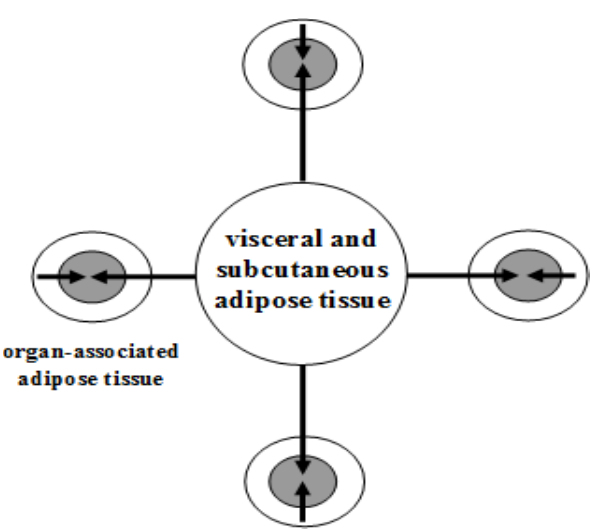
Figure 1. The topography of white adipose tissue. Schematic illustration of a large adipose depot (visceral and subcutaneous adipose tissue) and small adipose depots (organ-associated adipose tissue). Dual action of adipokines, via endocrine pathway (long arrows) and via paracrine pathways (short arrows), on adipose tissue-associated organs is depicted. From: [8] (reproduced with permission).